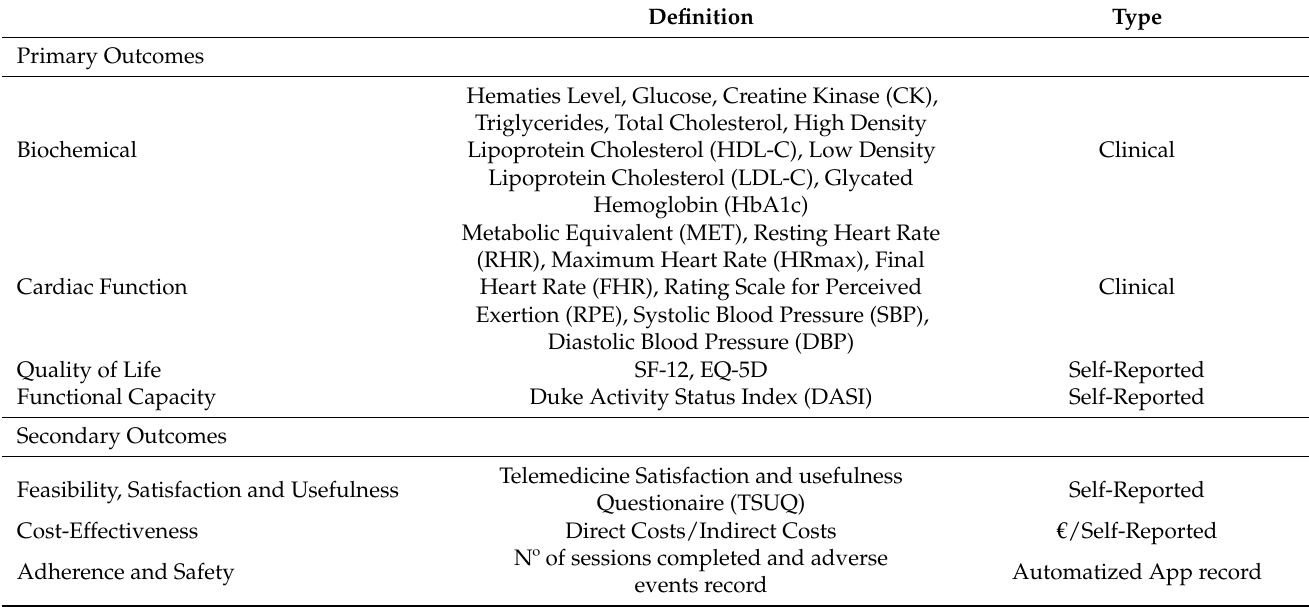
Table 2. Primary and secondary